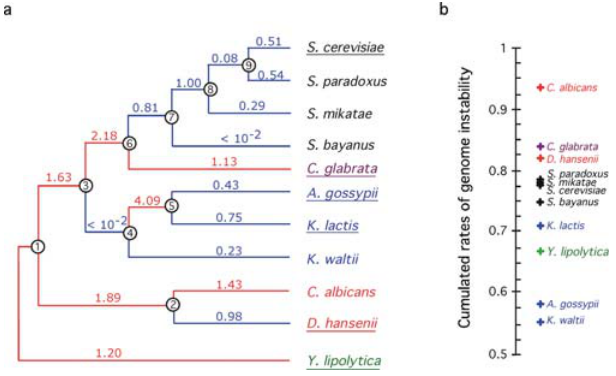
Figure 2. Rates of Genome Instability in Hemiascomycetes (A) Branch-specific normalized rates of genome rearrangements are indicated either in red or in blue illustrating higher or lower rates than average, respectively. Nodes are numbered from 1 to 9. (B) Cumulated rates of genome instability correspond to the ratios between the sum of the branch-specific GOL and the phylogenetic distance separating each species from node 1 (Table 2). DOI: 10.1371/journal.pgen.0020032.g002